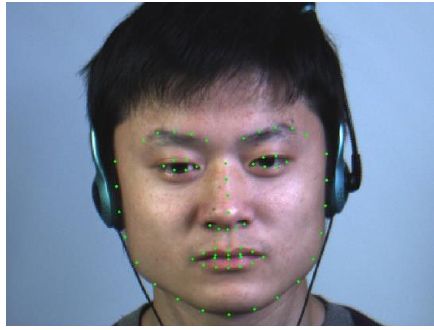
Figure 7. Sixty-six feature points.